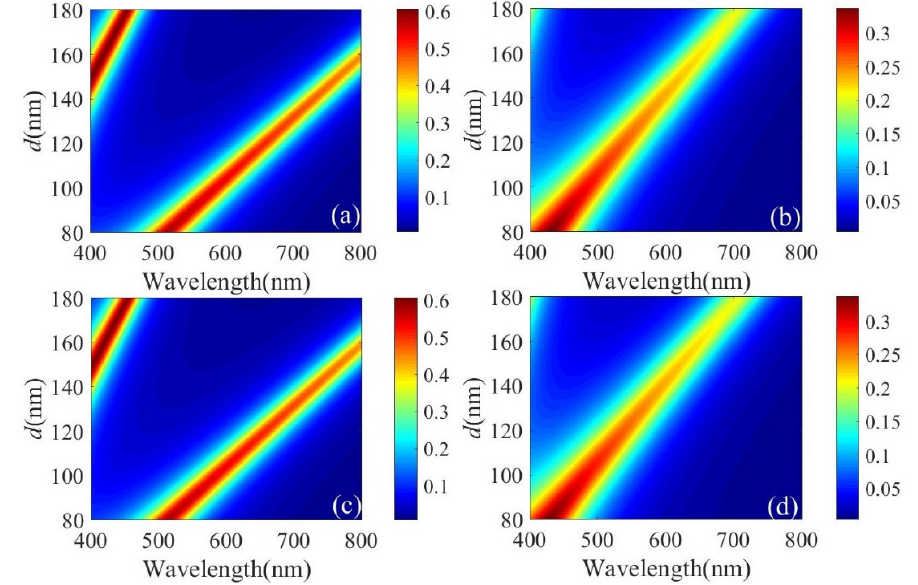
Figure 5. For TM polarization: ( a ) transmission spectra of different IGZO thicknesses before H 2 treatment and ( b ) after H 2 treatment. For TE-polarization: ( c ) transmission spectra of different IGZO thicknesses before H 2 treatment and ( d ) after H 2 treatment.